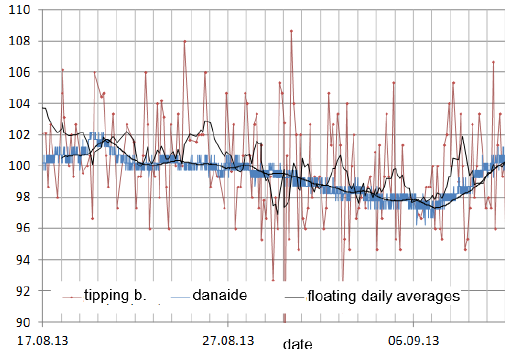
Fig. 9. V6 discharge variance [%] (rel. to time period average). Comparison between tipping bucket and danaide.